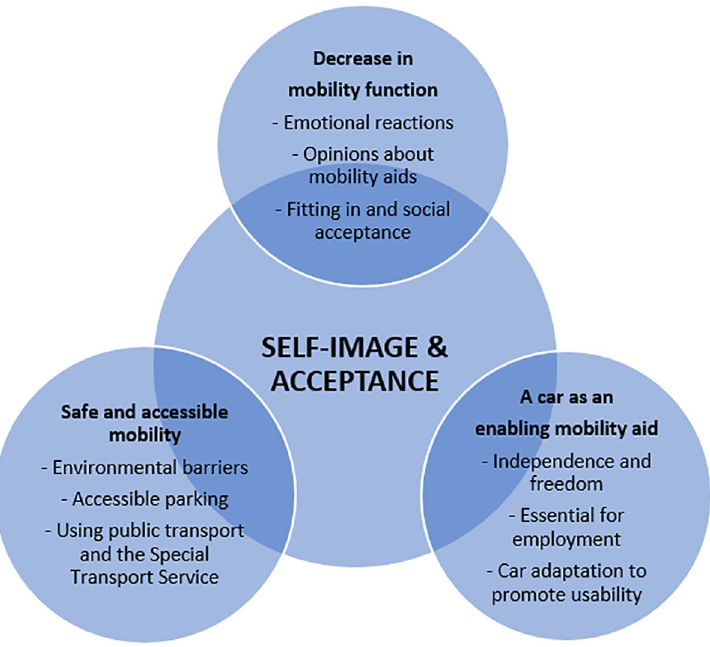
Fig 1. The theme “Self-image & acceptance” comprised an acceptance process affecting self image. There are, three categories and sub-categories influencing the participants’ experiences.